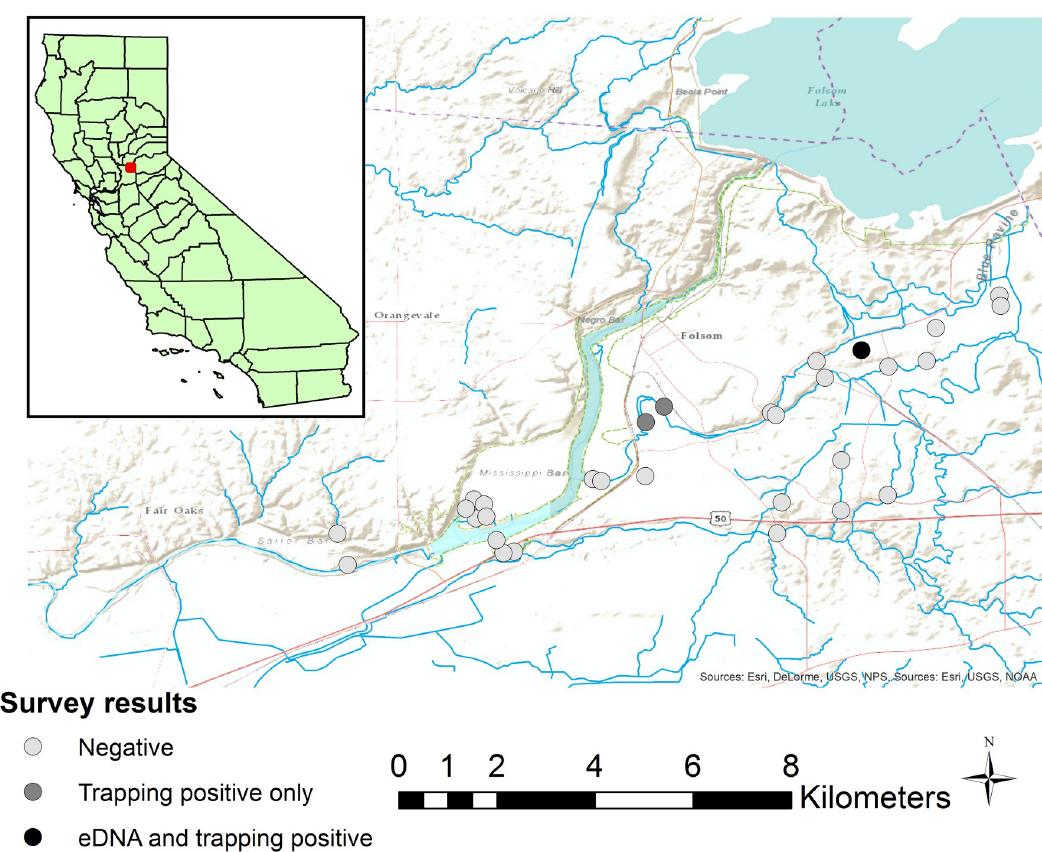
Fig 2. Location of sample sites for Nerodia fasciata . 30 sites sampled for the presence of Nerodia fasciata using eDNA, and for a subset of 10 sites, aquatic funnel traps.